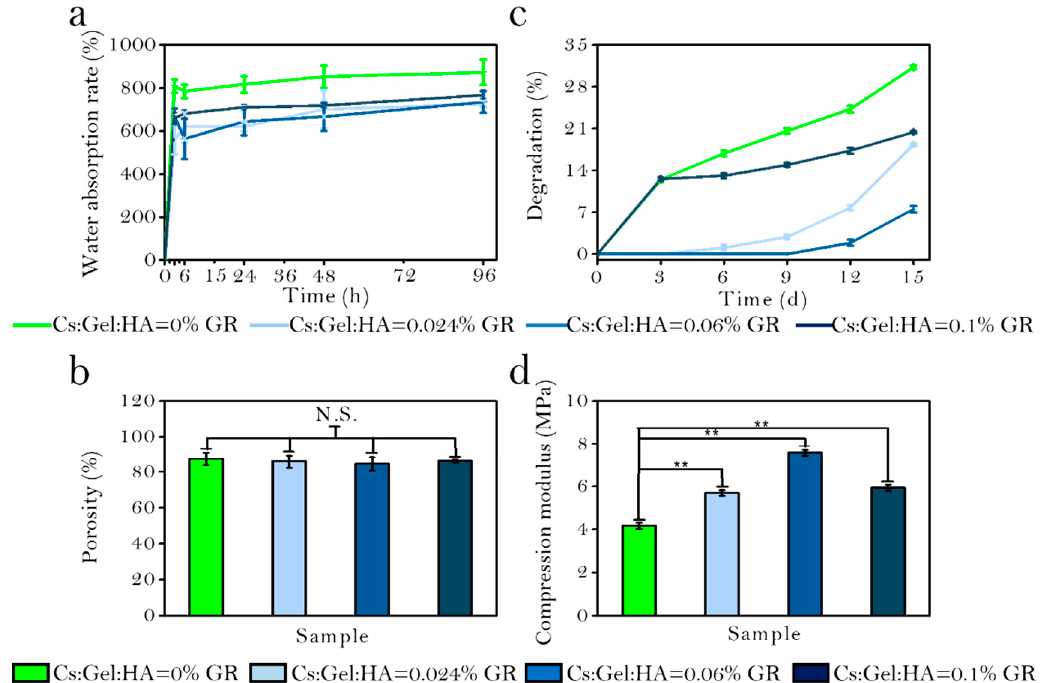
Figure 6. ( a ): Water absorption rate of bio-scaffolds; ( b ): Porosity of bio-scaffolds; ( c ): Degradation rate of bio-scaffolds; ( d ): Mechanical strength of bio-scaffolds; *** p< 0.001; **p< 0.01; **p< 0.05; N.S.: p ≥ 0.05: no significant difference .